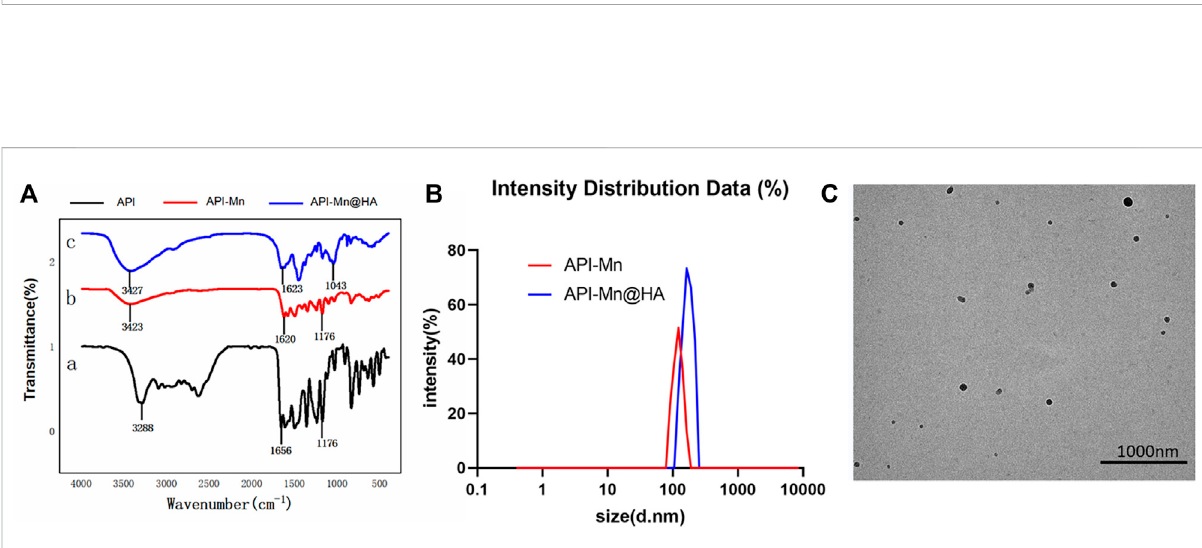
FIGURE 2 Characterizations of polymers. (A) . Infrared spectrogram of API-Mn(II) complex and API-Mn(II)@HA nanoparticles. [a.API, b.API-Mn(II)@HA nanoparticles, c.API-Mn(II) complex] (B) Size distribution of API-Mn and API-Mn@HA. (C) TEM images of